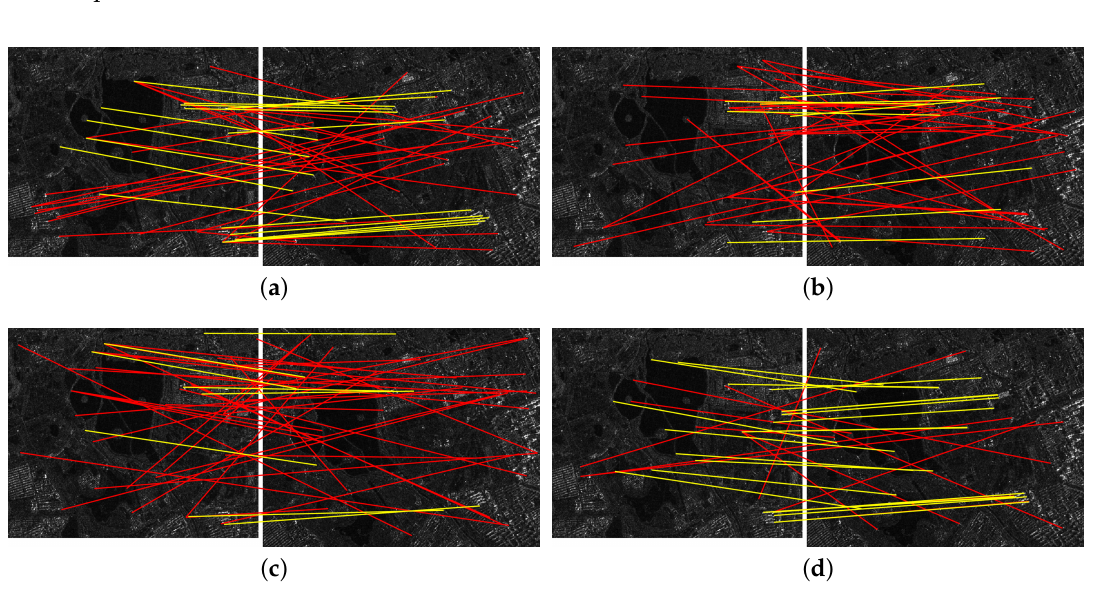
Figure 8. Matching results on second image pair. ( a ) SAR-SIFT; ( b ) BFSIFT; ( c ) SIFT; ( d )